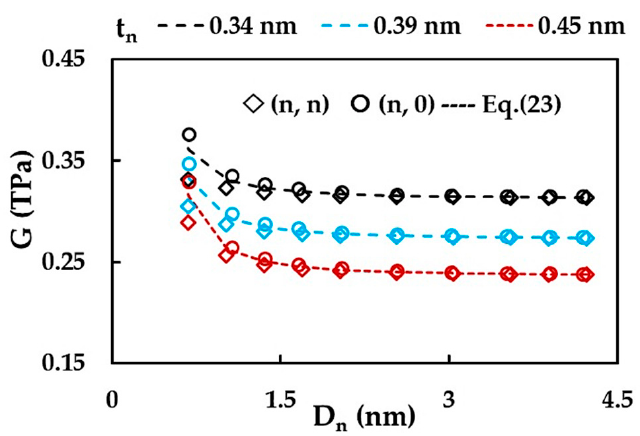
Figure 11. Evolutions of the shear modulus, G, with the NT diameter, D n , for SWSiCNTs, considering the NT wall thickness, for t n = 0.34 nm, 0.39 nm and 0.45 nm.